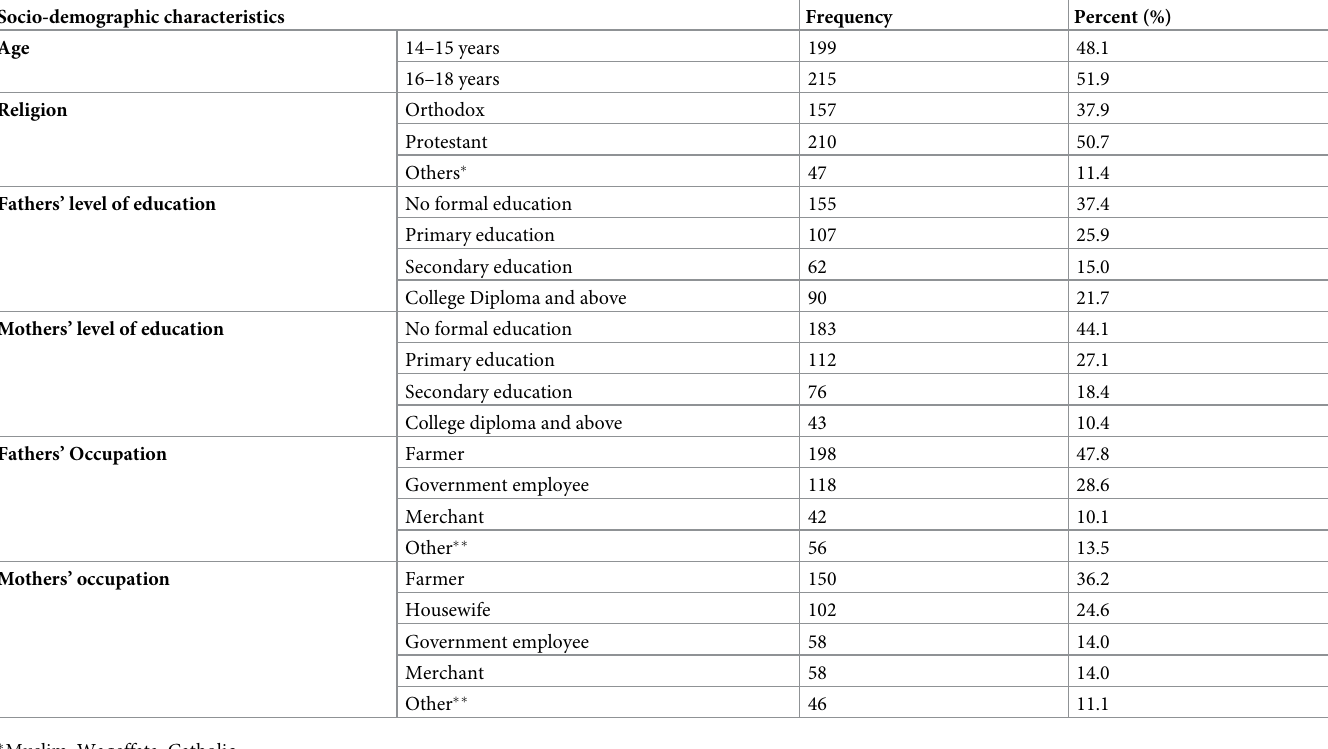
Table 1. Socio-demographic characteristics, of adolescent school girls in Ambo town, Ethiopia, 2020 (n = 414). Socio-demographic